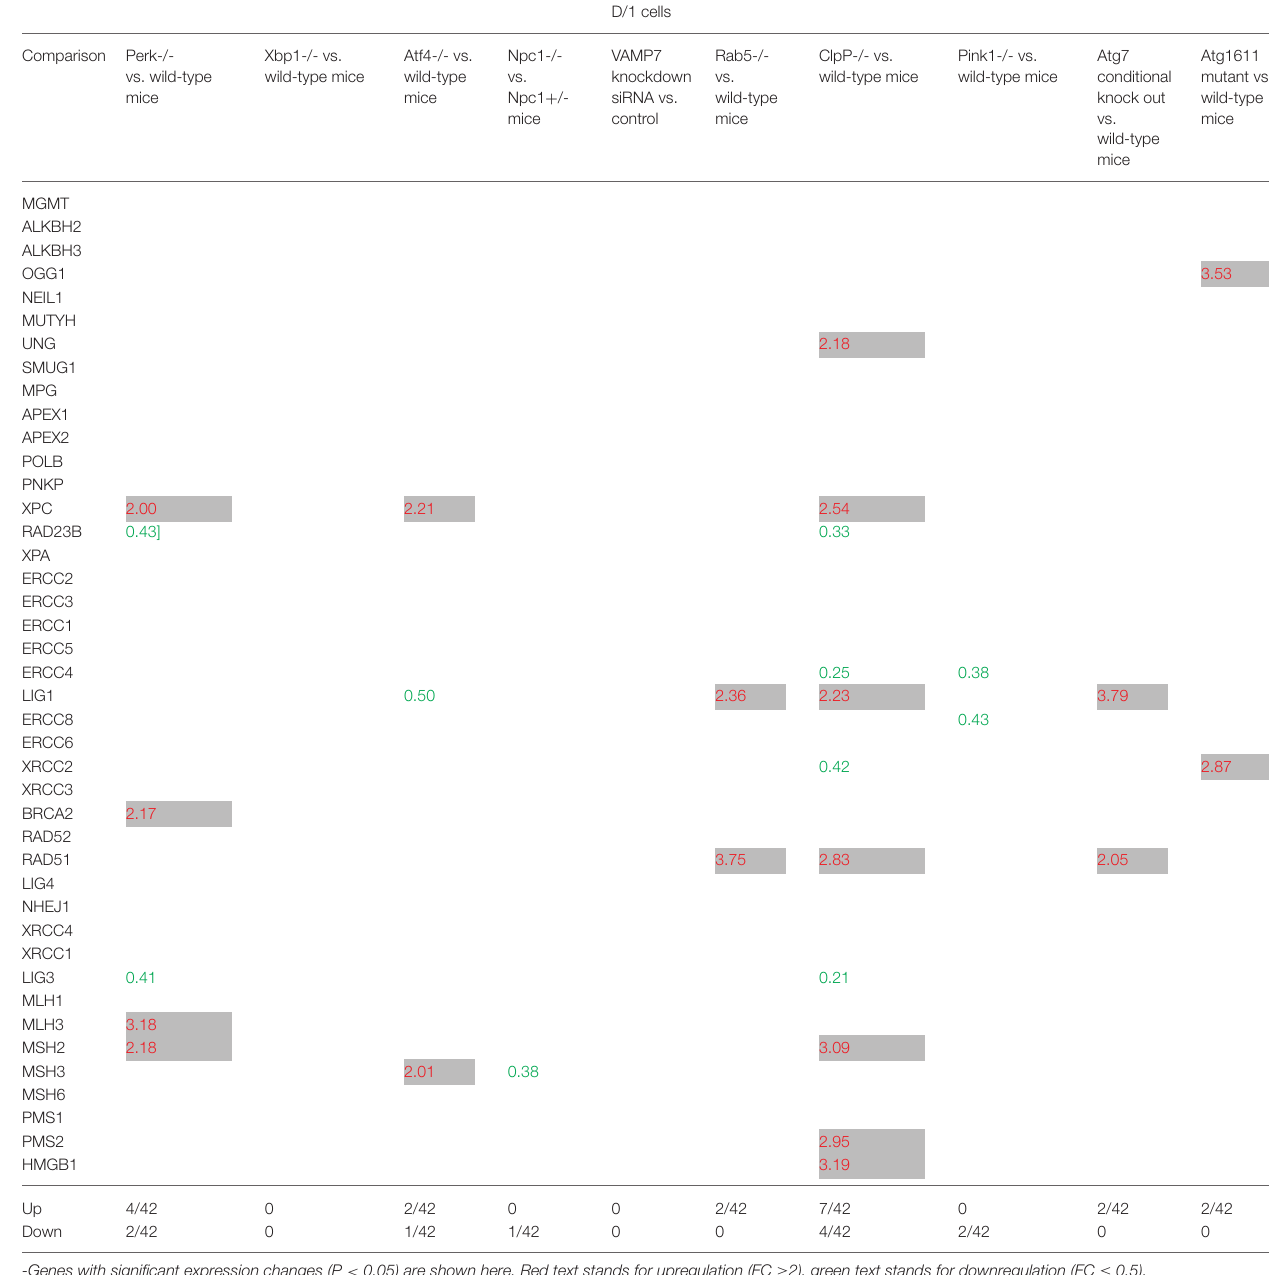
Frontiers in Physiology |